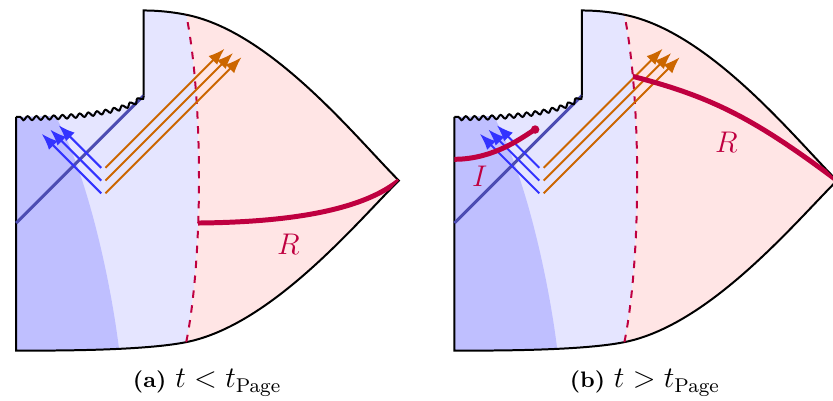
Figure 4. (a) Before the Page time, there is no island, and the entropy of the Hawking radiation is just given by the bulk entropy on the surface R . (b) After the Page time, enough entanglement has been built up by the Hawking process for an island to appear inside the black hole. Accounting for this in the island formula reproduces the Page